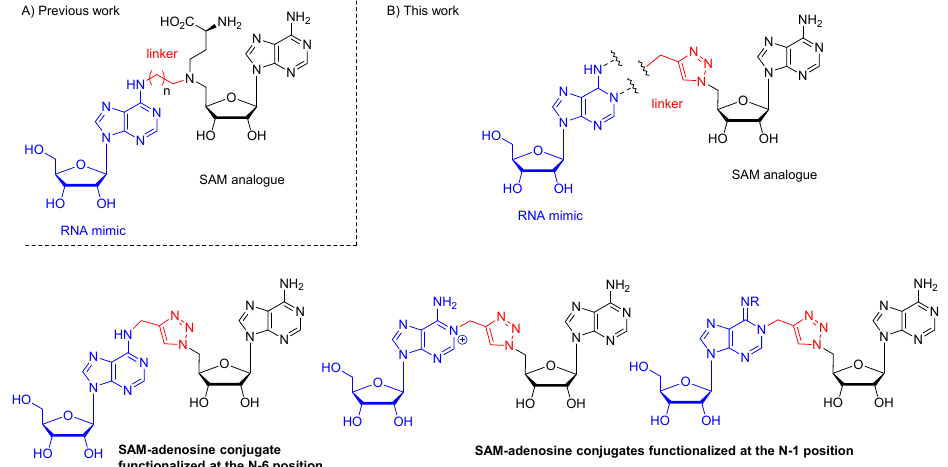
Figure 1. ( A ) Our previous work: structure of SAM-adenosine conjugates with an alkyl linker [25,26]; ( B ) structure of SAM-adenosine conjugates with a 1,2,3-triazole linker synthesized in this study.